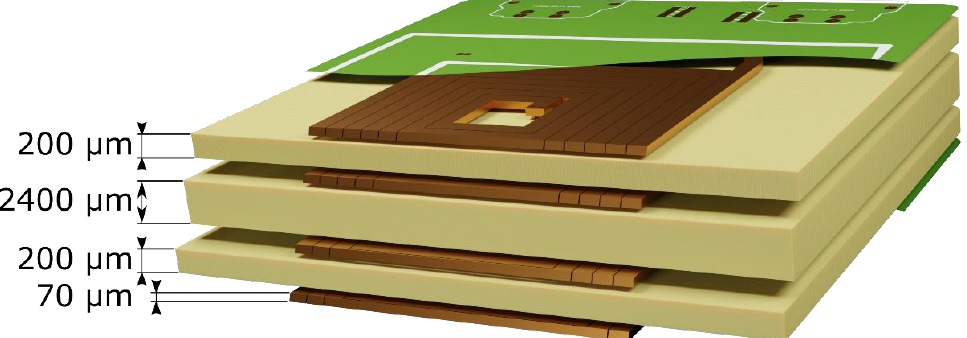
Figure 1. Schematic sectional view of the Square PCB transformer, showing the layer structure. The connection between the individual coils on different layers is made by blind vertical interconnect accesses (vias). These vias connect the outer layer with the adjacent inner layer for one coil, and the same applies to the other coil. In addition to the Square coil, four other coil geometries were investigated, for which the above-mentioned parameters such as track width, track thickness, track spacing, number of turns and layer structure, were also used. The different coil geometries are shown in Figure 2. The second half of the coil looks identical and is mirrored on the adjacent